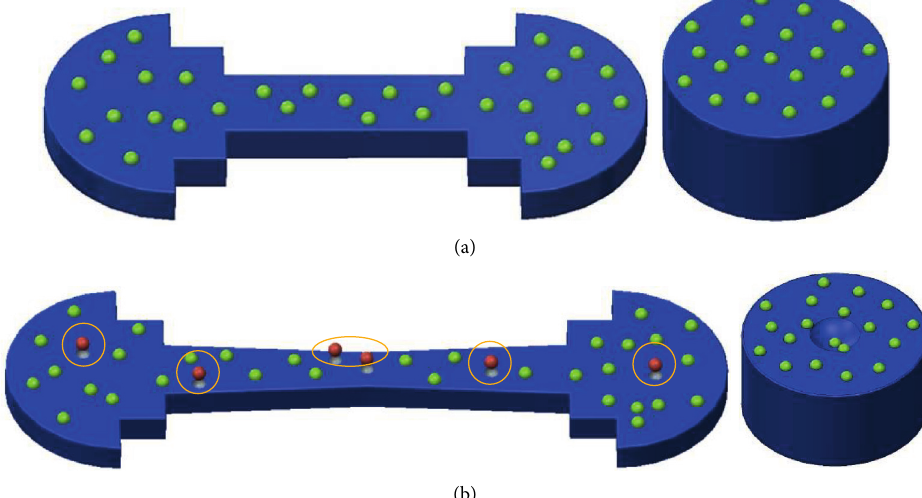
Figure 10: Schematic diagrams of AR specimens (a) before stretching (compressing) and (b) after stretching (compressing).